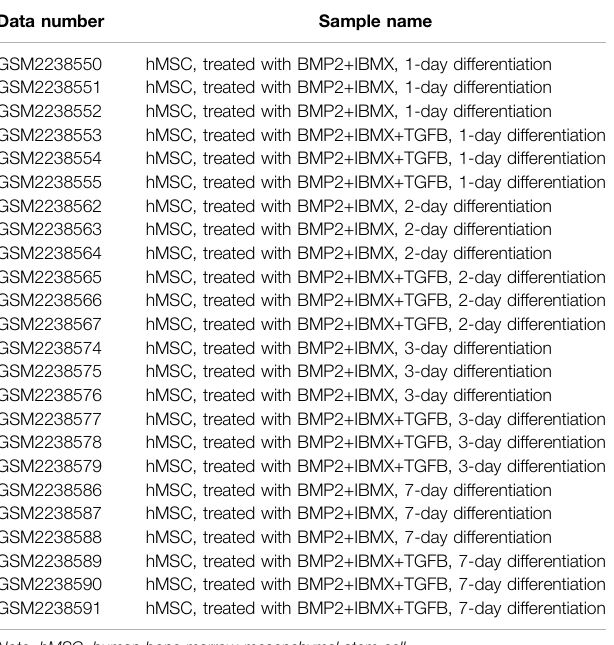
TABLE 1 | Summary of the 24 samples.